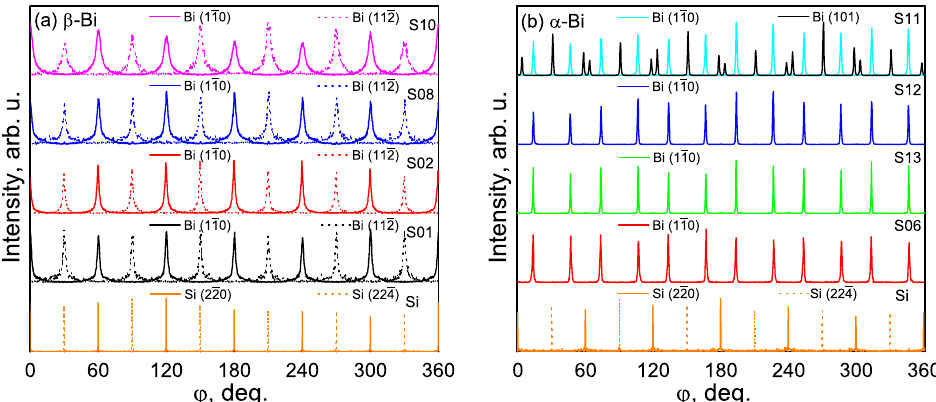
Figure 5. In-plane φ scans of (110) (solid lines) and (112) (dashed lines) planes for β -Bi ( a ) and in-plane φ scans of (110) and (101) (to avoid confusion is shown only for S11) planes for α -Bi ( b ). Si (220) (solid lines) and Si (224) (dashed lines) φ scans are given in both pictures for the evaluation of the azimuthal orientation between the substrate and the layer.